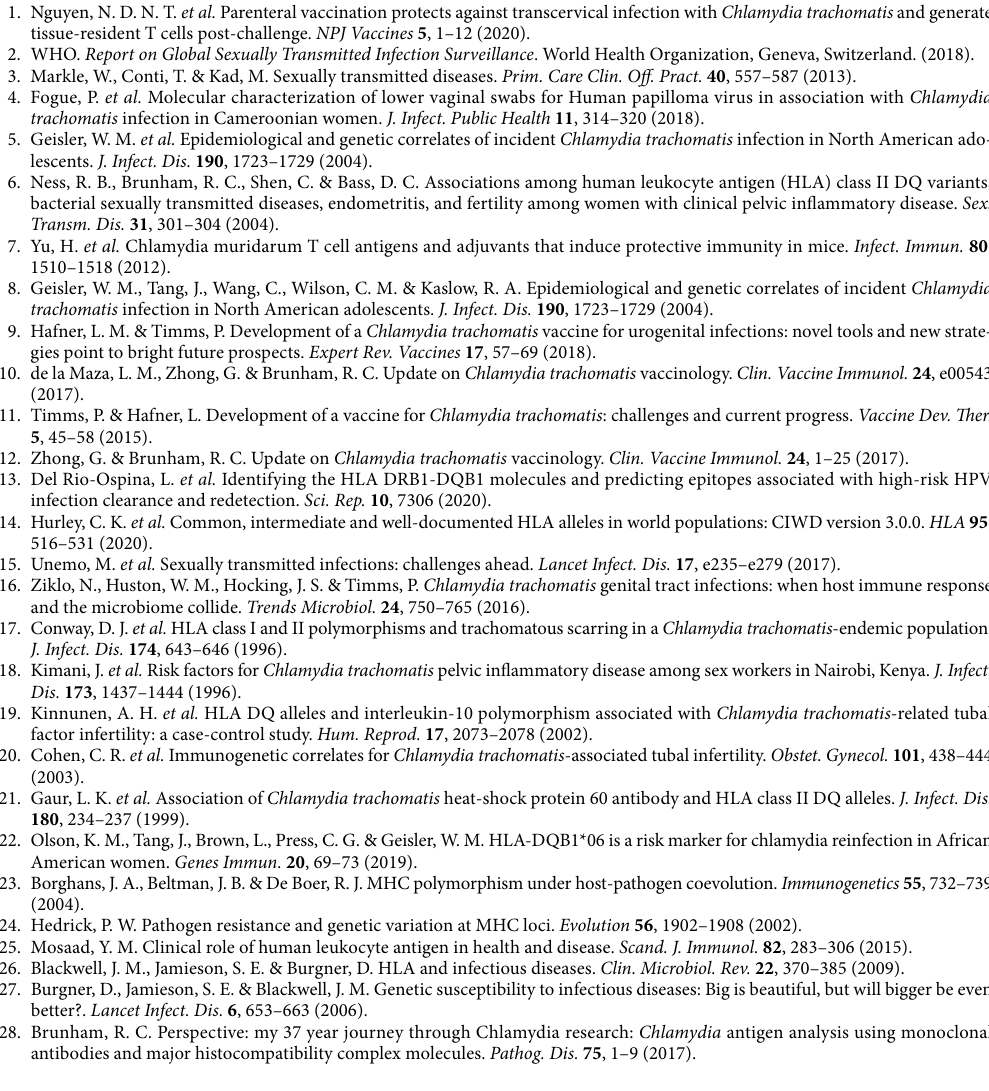
Table S25) were downloaded from the PATRIC 3.5.11 database (https:// www. patri cbrc. org) and analysed first using classical pathway secretion predictor (SignalP 5.0) 42 and those not assigned by this predictor were analysed by the non-classical one, SecretomeP 2.0 43